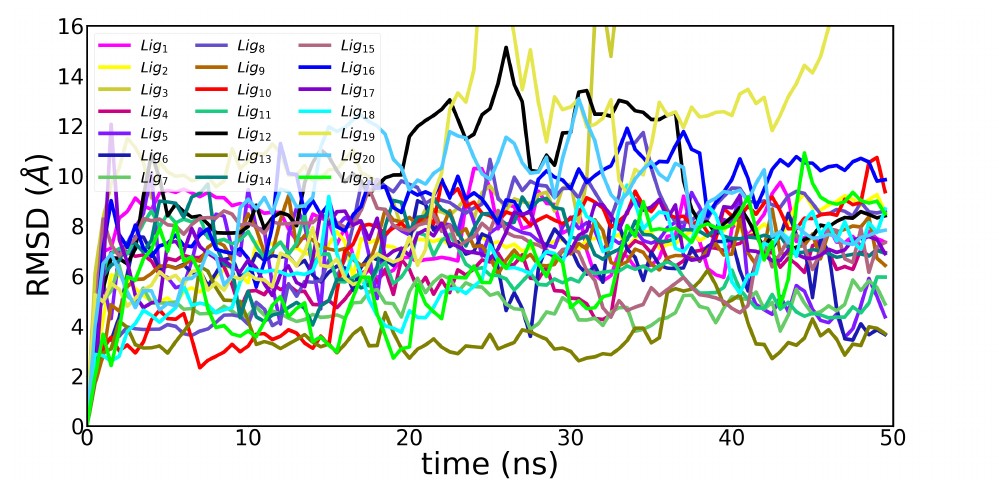
Figure A4. Root means square displacement (RMSD) of the simulated ligands. The RMSD is calculated based on a trajectory in which the protein backbone was aligned with itself.